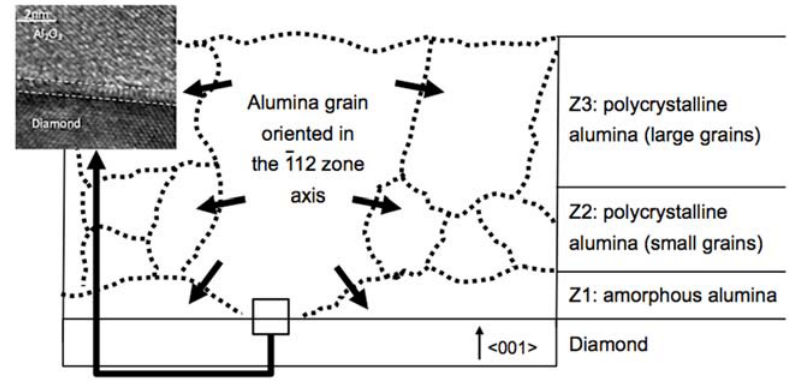
Figure 5. Schema of the grain evolution on γ‐ alumina grown on a diamond by ALD. The inset is a HREM micrograph of the alumina–diamond interface when amorphous alumina was not